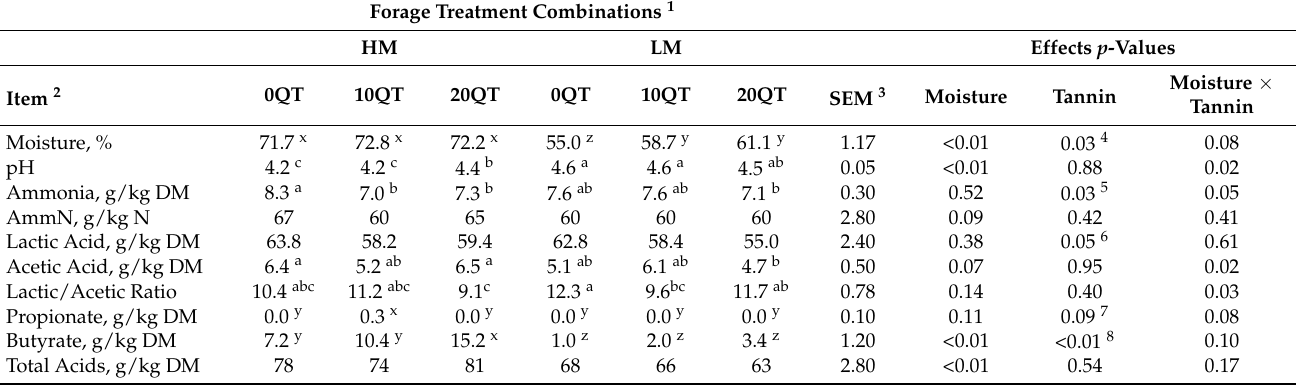
Table 3. Post-ensiled fermentation parameters of tall fescue ensiled in laboratory silos at different moistures without quebracho tannin (QT) or with tannin at 10 (10QT) or 20 (20QT) g/kg total silage